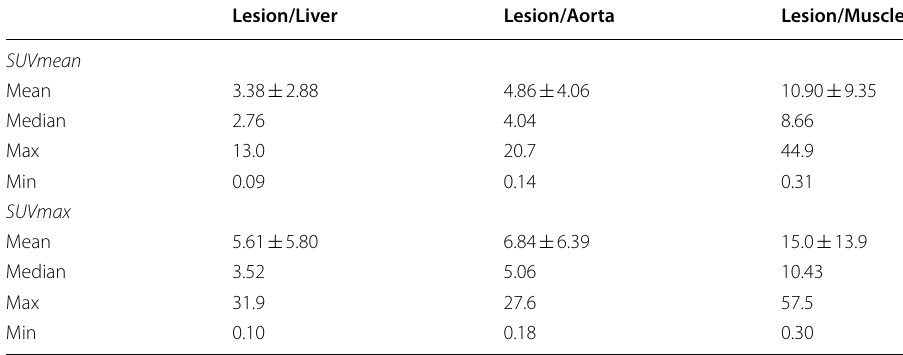
Lesion normalized to different background Table 3 describes lesion normalized to liver, aorta, and muscle background regions. After SUVmax lesion normalization with respect to the three background sites, the 127.0, p < 0.001) difference in the mean ranks Friedman test showed a significant ( χ 2 =